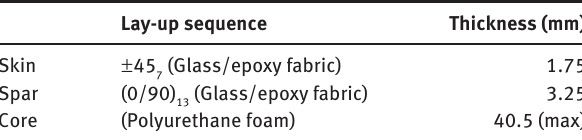
Table 4 Designed lamination sequence and